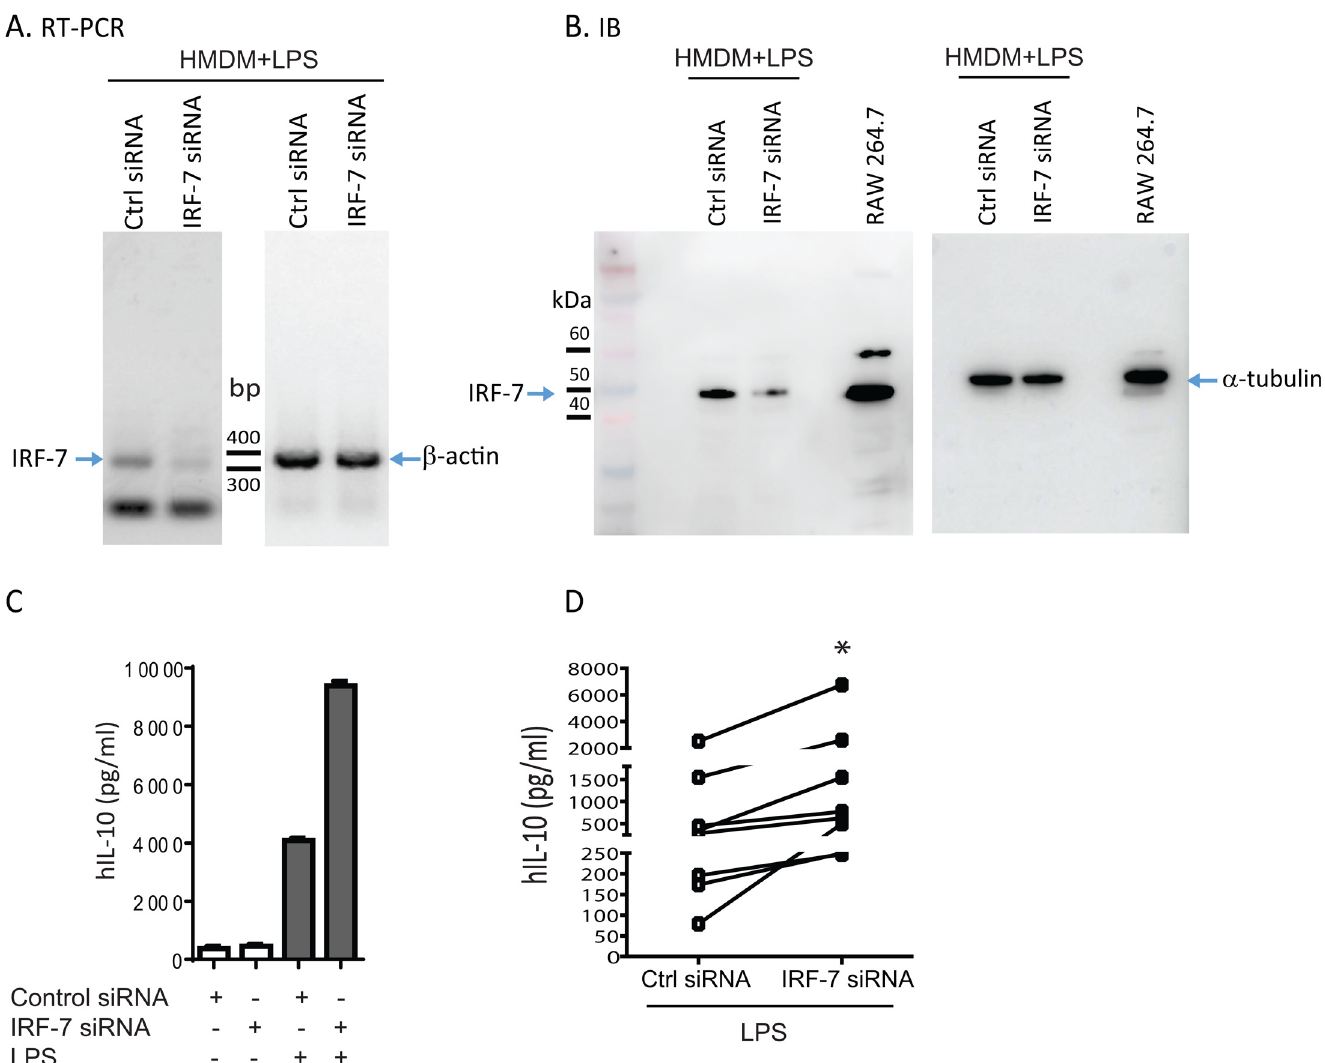
Fig 4. IRF7 gene knockdown enhances LPS-induced human macrophage IL-10 production. Human monocyte derived macrophages were isolated from the peripheral blood of healthy volunteers and cultured for 5 days in RPMI 1640 media containing fresh media with 10% autologous serum and recombinant human-M-CSF (50 ng/ml) before transfection with control siRNA or IRF-7 siRNA. The cells were stimulated in the presence or absence of ultrapure LPS (100 ng/ml, E . coli 0111:B4) for 24 hours. (A) RT-PCR for IRF-7 was performed and confirmed gene knockdown with IRF-7 specific pooled siRNA as compared to control siRNA-treated cells after exposure to LPS (expected amplicon size IRF-7: 327 bp). β -actin gene was used as a house- keeping gene controlling for input sample quantity (expected amplicon size β -actin: 353 bp). (B) IRF-7 siRNA treated cells showed attenuated IRF-7 protein expression by immunoblotting, when compared to control siRNA treated cells in the presence of LPS (expected band size IRF-7 ~50 kDa). Alpha tubulin was used as loading control. Unstimulated RAW264.7 cell lysates were used as positive control for IRF-7. (C) Cell culture supernatants from HMDM were harvested for quantification of IL-10 production by ELISA. IRF-7 knockdown enhances IL-10 production in the presence of LPS. IL-10 production is minimal in the absence of LPS. (D) Composite of 8 independent experiments showing significant increase in IL-10 production by ELISA in supernatants of IRF-7 siRNA treated HMDMs compared to control siRNA in the presence of LPS. Each point represents matched samples, ( * p-value < 0.05 Wilcoxon matched-pairs sign rank test, n =